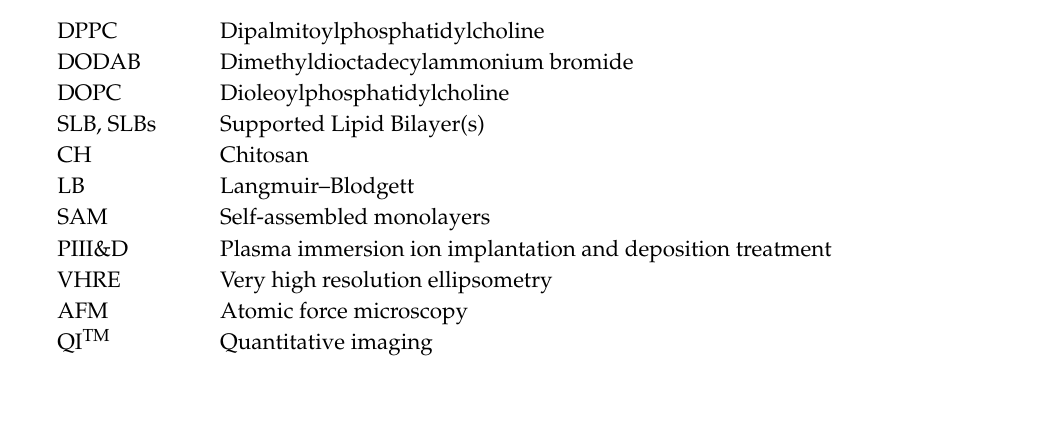
sample NE01 ramp number 7, Figure S3: Temperature ramp ∆ P( ◦ ) vs. T(K) corresponding to sample NE01 ramp number 8, Figure S4: Temperature ramp ∆ P( ◦ ) vs. T(K) corresponding to sample H14 ramp number 3, Figure S5: Temperature ramp ∆ P( ◦ ) vs. T(K) corresponding to sample H14 ramp number 6, Figure S6: Temperature ramp ∆ P( ◦ ) vs. T(K) corresponding to sample H15 ramp number 5, Figure S7: Temperature ramp ∆ P( ◦ ) vs. T(K) corresponding to sample H15 ramp number 6, Figure S8: Temperature ramp ∆ P( ◦ ) vs. T(K) corresponding to sample H16 ramp number 6, Figure S9: Temperature ramp ∆ P( ◦ ) vs. T(K) corresponding to sample H16 ramp number 7, Table S4: Values for the temperatures of three di ff erent phase transitions obtained from 48 ellipsometric measurements on 8 di ff erent samples, Figure S10: Adhesion maps obtained using QI TM mode for sample H14 (a) 296 K (b) 308 K and (c) 323 K and sample H15 (d) 296 K (e) 313 K and (f) 323 K, Figure S11: Topographical images of DPPC bilayer during the heating-cooling temperature cycle, Figure S12: (a) Adhesion map of silicon at room temperature after a complete heating-cooling cycle corresponding to image Figure 5 (e). (b) Histogram of the white rectangle shown in the adhesion map that represents the substrate, silicon, Figure S13: Topographical image and cross section of the image corresponding to (a) Figure 6c and (b) Figure 6f in the manuscript, Figure S14: AFM images and histograms of (a) DPPC on SiO 2 / Si two hours after evaporation and (b) nine months later; Video S1: QI TM mode time independent AFM measurements at room temperature at 1 nN and 3